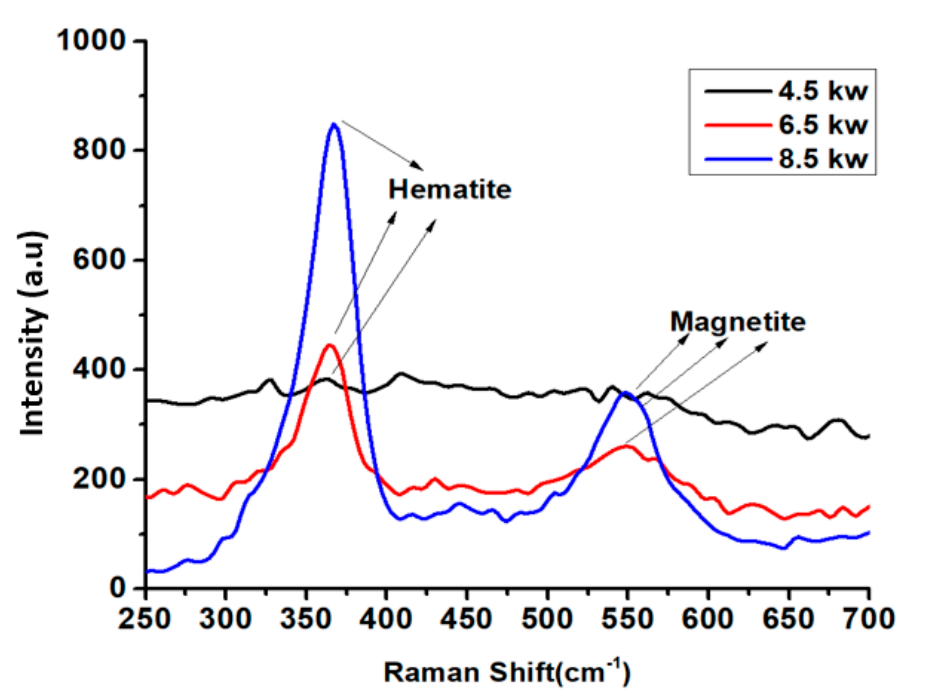
Figure 9. Raman spectra of the passive film formed at 4.5 kW, 6.5 kW and 8.5 kW on 2205 duplex stainless steels.